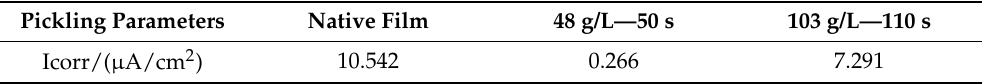
Table 2. Corrosion current densities of the pre-passivation films with different pickling conditions. Pickling